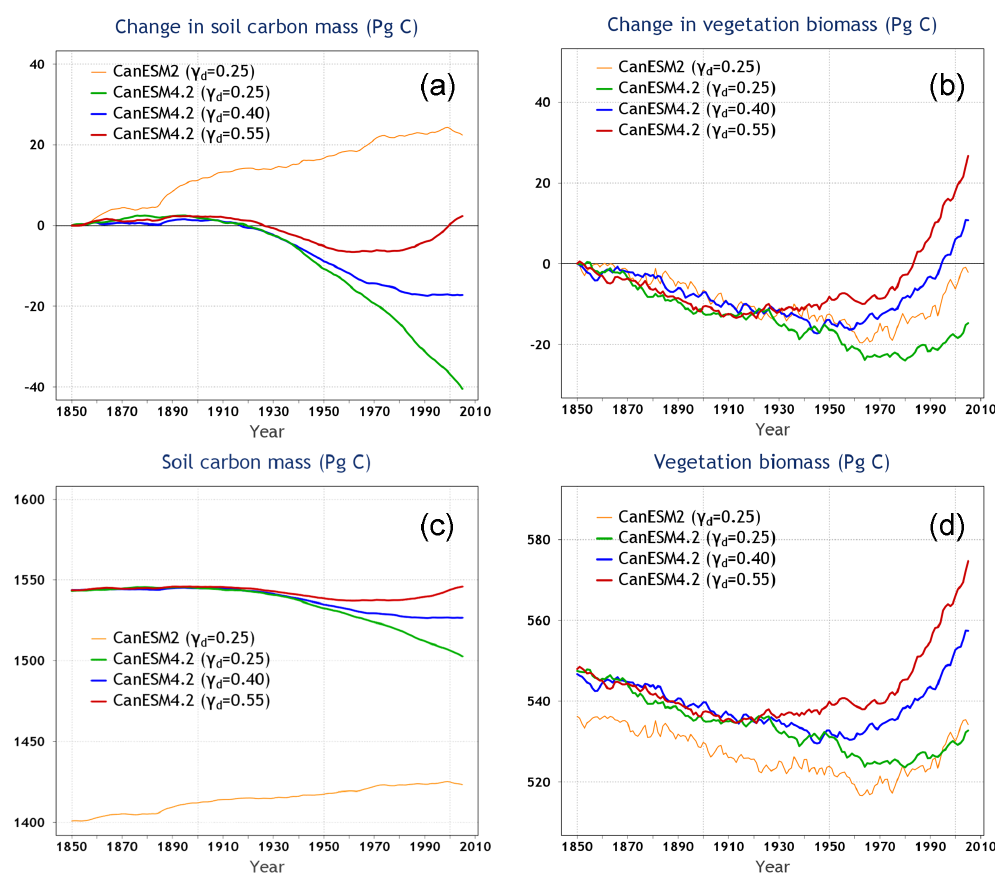
Figure 5. Change in and absolute values of global soil carbon and vegetation biomass amounts from CanESM2 and the three CanESM4.2 historical 1850–2005 simulations with different strengths of the terrestrial CO 2 fertilization effect. The results shown in all panels are the average of the two ensemble